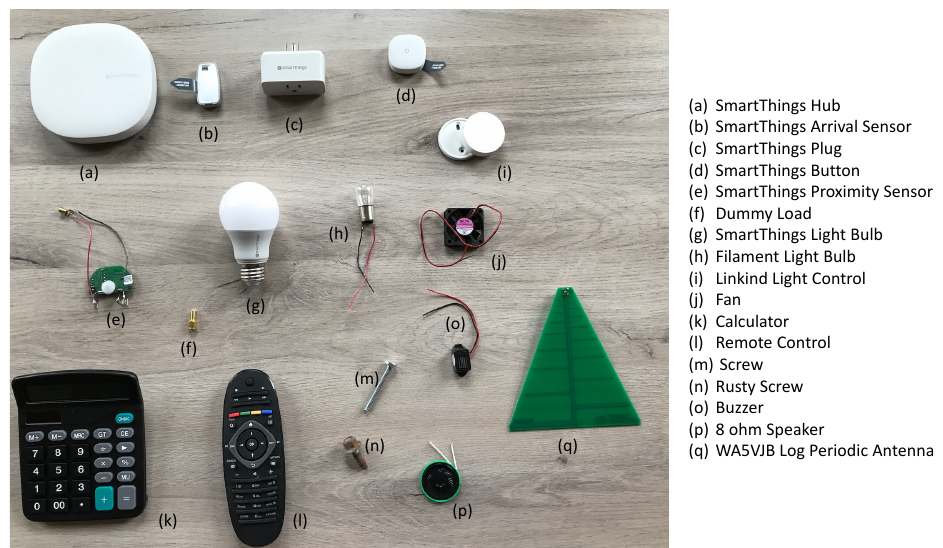
Figure 4. An image of the target devices used in our experiments, along with the antenna (q) used for transmitting and receiving the probe signal. Not shown in the picture is the laptop shown later in Figure